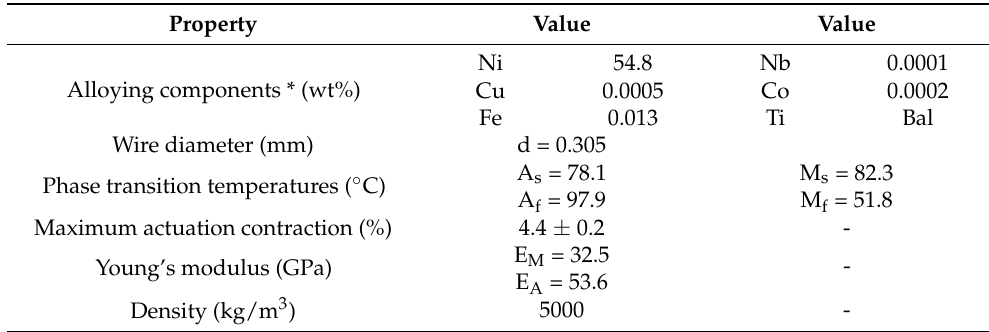
Table 5. Material properties of the NiTi SMA wire